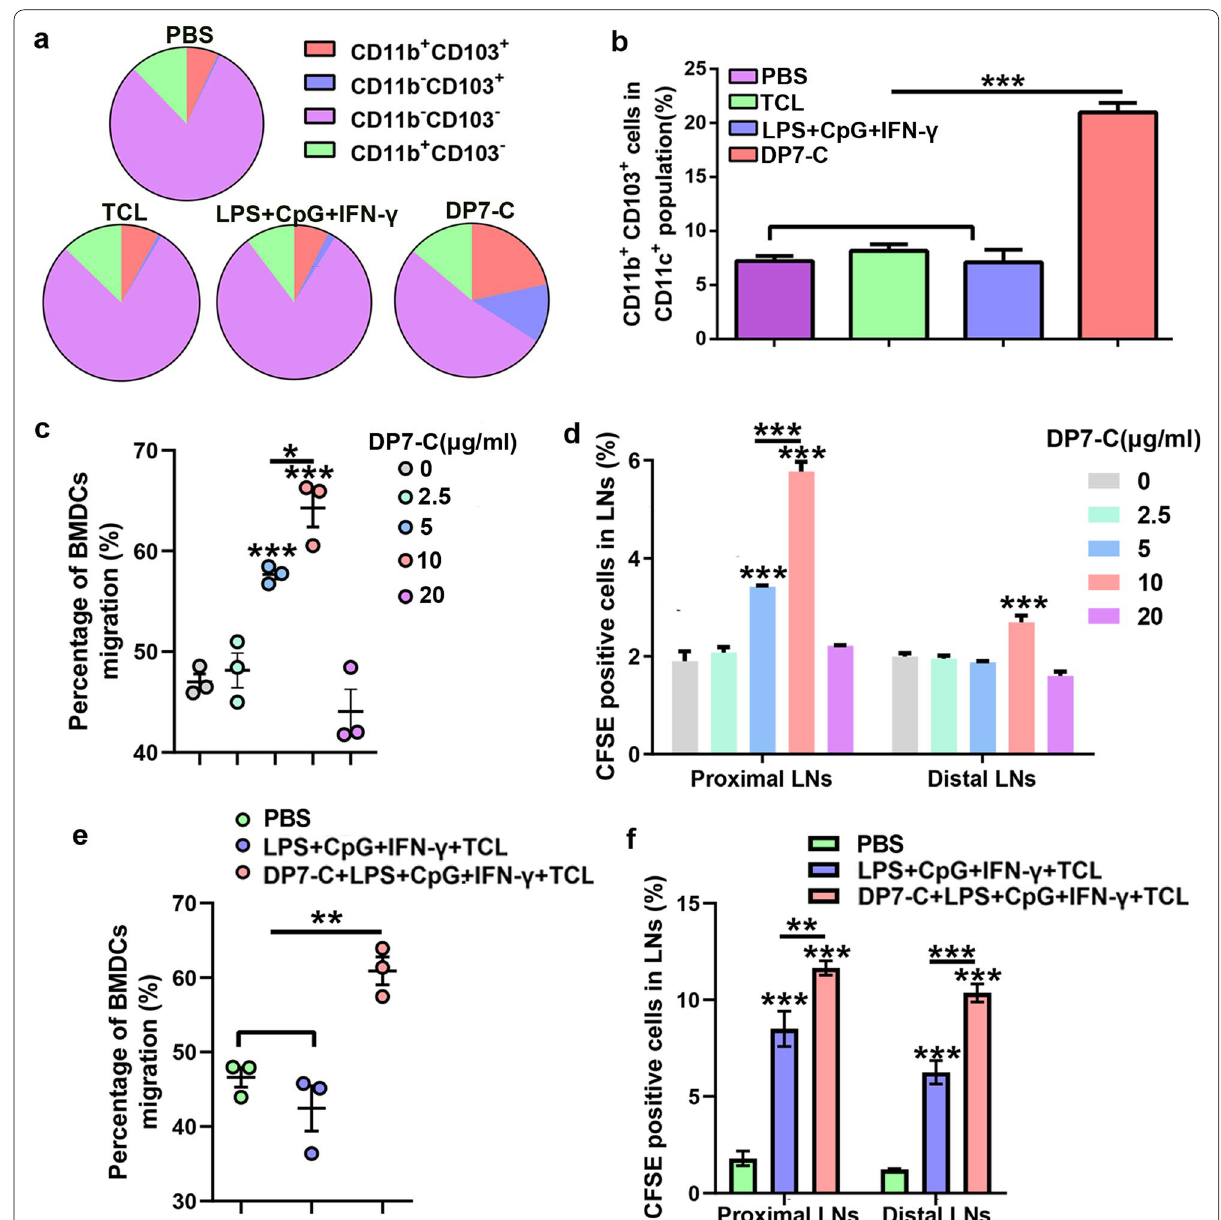
Fig. 3 DP7-C enhances DC migration in vivo and in vitro. a‑b . Flow cytometry was performed to detect the percentage of CD103 + DCs among all DCs after different treatments. c . Transwell assays showed that DP7-C enhanced the migration of DC in vitro (the lower chambers contained 500 μl of RPMI 1640 medium with 10% FBS CCL19 (250 ng/ml) CCL21 (250 ng/ml)) . d . Flow cytometry revealed that DP7-C enhanced the LNs homing + + of CFDA-SE labeled DCs ( n 3). e . Transwell assays were used to detect the migration of DCs in vitro after different treatments. f . Flow cytometry = detection of different treatments and their effects on the LN homing of CFDA-SE labeled DCs ( n 3). Proximal LNs were the inguinal lymph node = on the same side as the DCs injection, and Distal LNs were the inguinal lymph node on the other side from the DCs injection. Significance was calculated using a one-way ANOVA with multiple comparisons tests. (* p < 0.05, ** p < 0.01, *** p <